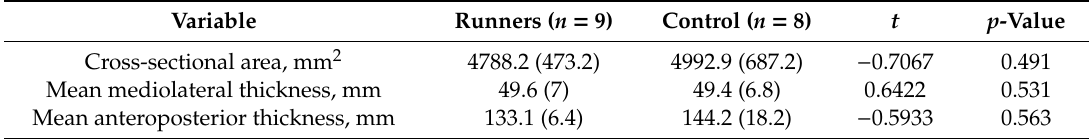
Table 3. Multifidus morphology in runners ( n = 9) and controls ( n = 8). Variable Runners ( n = 9) Control ( n = 8) t p -Value Cross-sectional area, mm 2 4788.2 (473.2) 4992.9 (687.2) − 0.7067 0.491 Mean mediolateral thickness, mm 49.6 (7) 49.4 (6.8) 0.6422 0.531 Mean anteroposterior thickness, mm 133.1 (6.4) 144.2 (18.2) − 0.5933 0.563